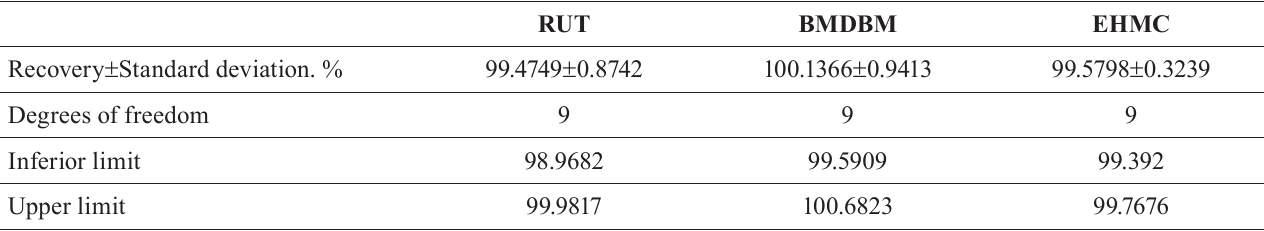
TABLE VI - Accuracy values obtained from Student’s t-test ( α = 0.05) RUT EHMC Recovery ± Standard deviation. %